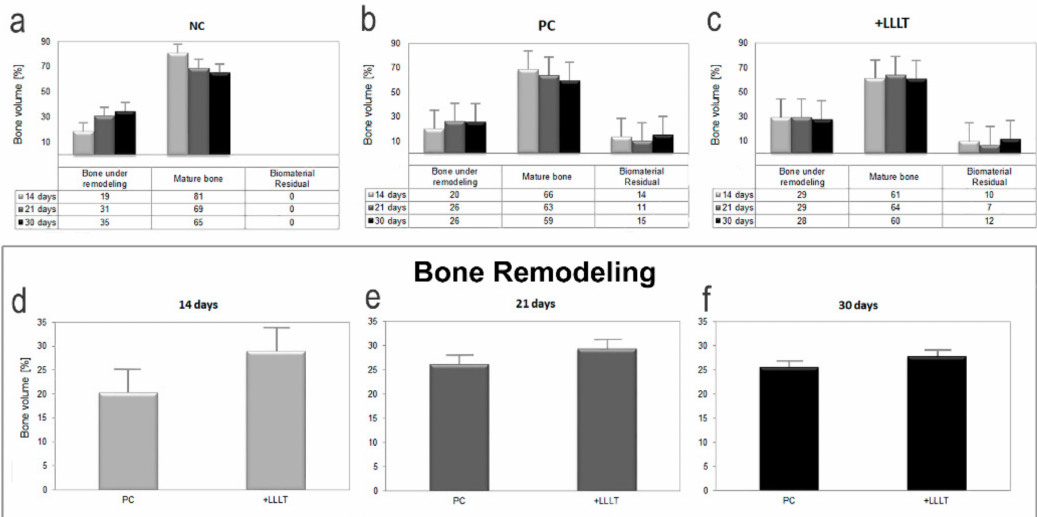
Figure 2. Quantitative morphometric analysis. ( a – c ) Mean volume percentages (vol.%) of the di ff erent mineralized phases (bone under remodeling, mature bone, and xenograft biomaterial) with respect to the overall mineralized volume: ( a ) NC group; ( b ) PC group; ( c ) + LLLT group. ( d – f ) Quantitative volumetric analysis of bone under remodeling portion, after ( d ) 14 days, ( e ) 21 days, and ( f ) 30 days from the surgery. Error bars are